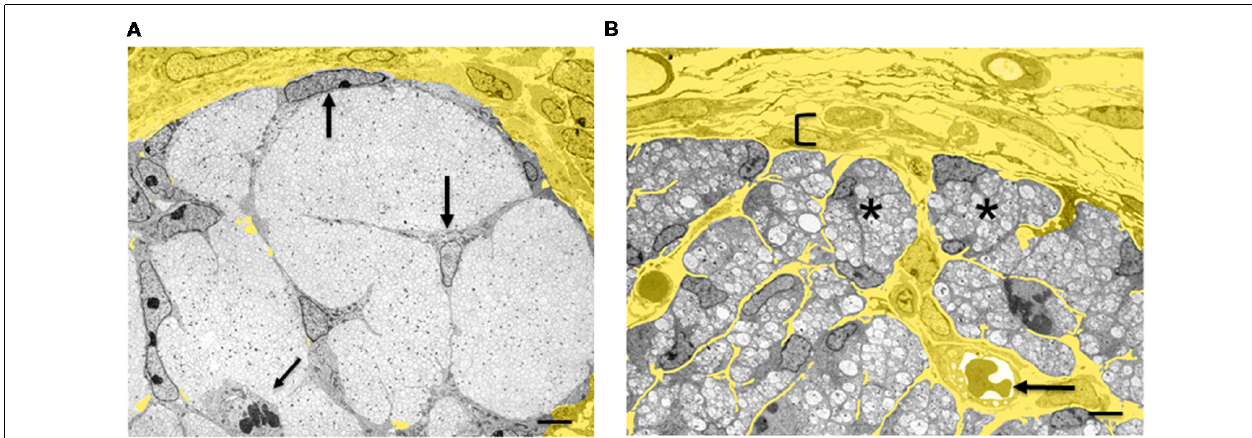
FIGURE 4 | Architectural reorganization of developing nerves. (A) Electron micrograph of a transverse section through E14 rat sciatic nerve. SCP are embedded among the axons and at the surface of the nerve (big arrows). A dividing SCP is also seen (small tilted arrow). Note that connective tissue (yellow) surrounds the nerve, but is not found inside the nerve. (B) Electron micrograph of a transverse section through E18 rat sciatic nerve. iSch surround the collection of axons, forming compact groups (“families”; examples indicated by asterisks). Extensive connective tissue (yellow) containing blood vessels (arrow) is now found inside the nerve surrounding the families, as well as outside the nerve. Bracket indicates the developing perineurium (scale bar: 4 µ m).